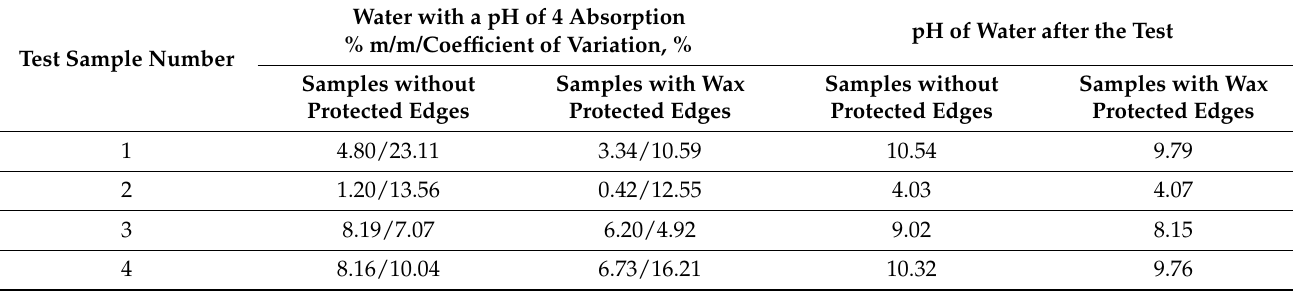
Table 4. Summary of results of water with a pH of 4 absorption test of polymer modified bituminous thick coatings.